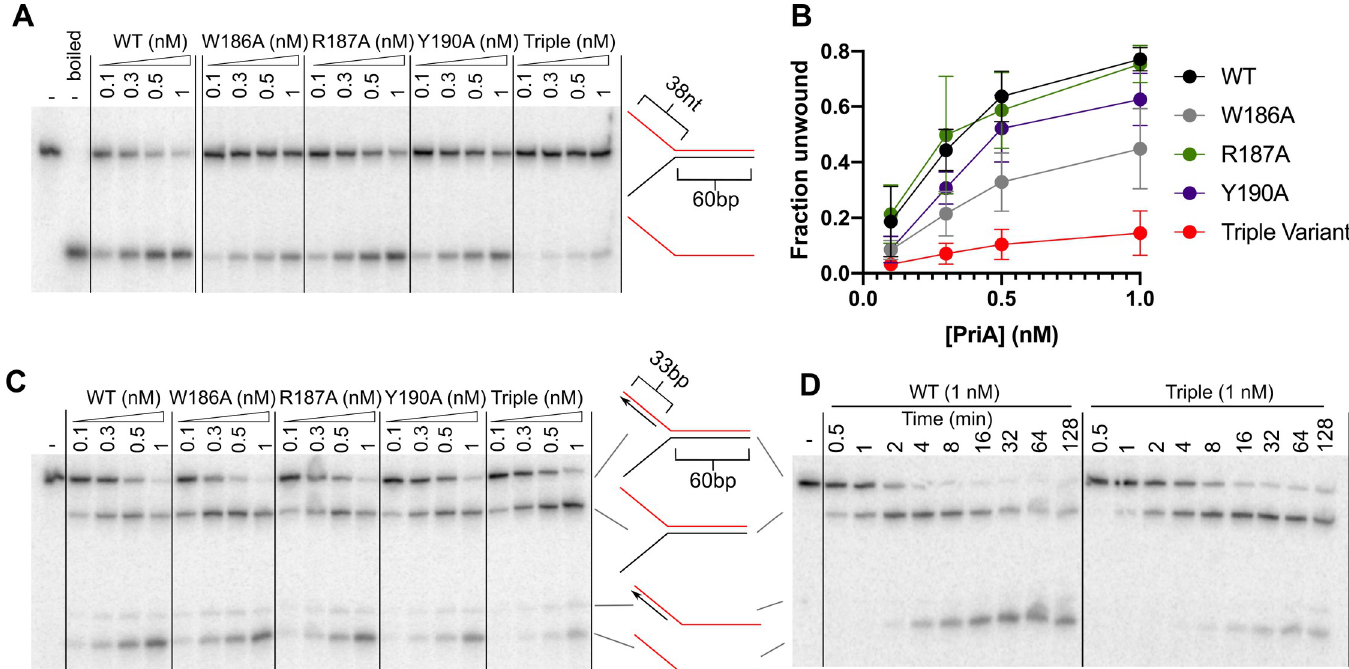
Fig 3. Parental duplex unwinding is impaired in PriA linker variants. (A) Unwinding products from incubation of two-stranded fork (0.5 nM, molecules) with PriA variants at concentrations shown and 2mM ATP. (B) Quantification of unwinding using ImageQuant software. Data points depict the mean of 4 replicate experiments, with error bars representing SD. (C and D) Unwinding products from incubation of three-stranded fork (0.5 nM, molecules) with PriA variants at concentrations shown and 2mM ATP. Assays are shown as 30-minute end-point (C) or time-course (D) experiments. Substrates are depicted with radiolabeled strand shown in red. Gels are representative of at least three